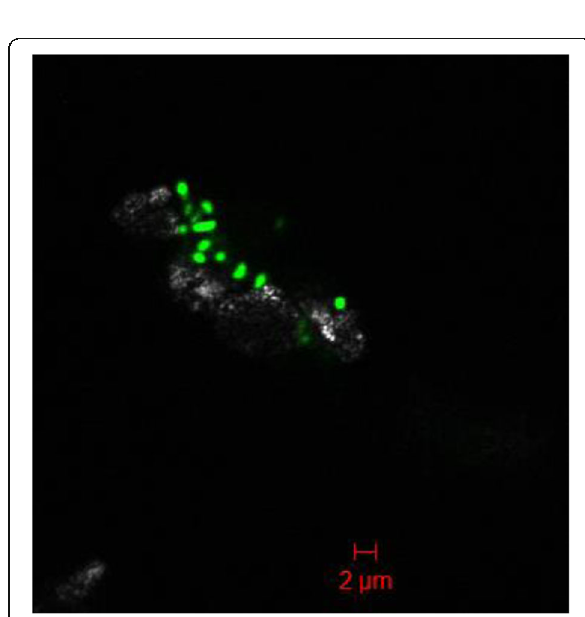
Fig. 8 Confocal microscopy of Bosea sp. WAO. Bosea sp. WAO (green) was stained with DAPI and imaged growing on the surface of a cadmium sulfide particle (faint white/grey) in a mostly black